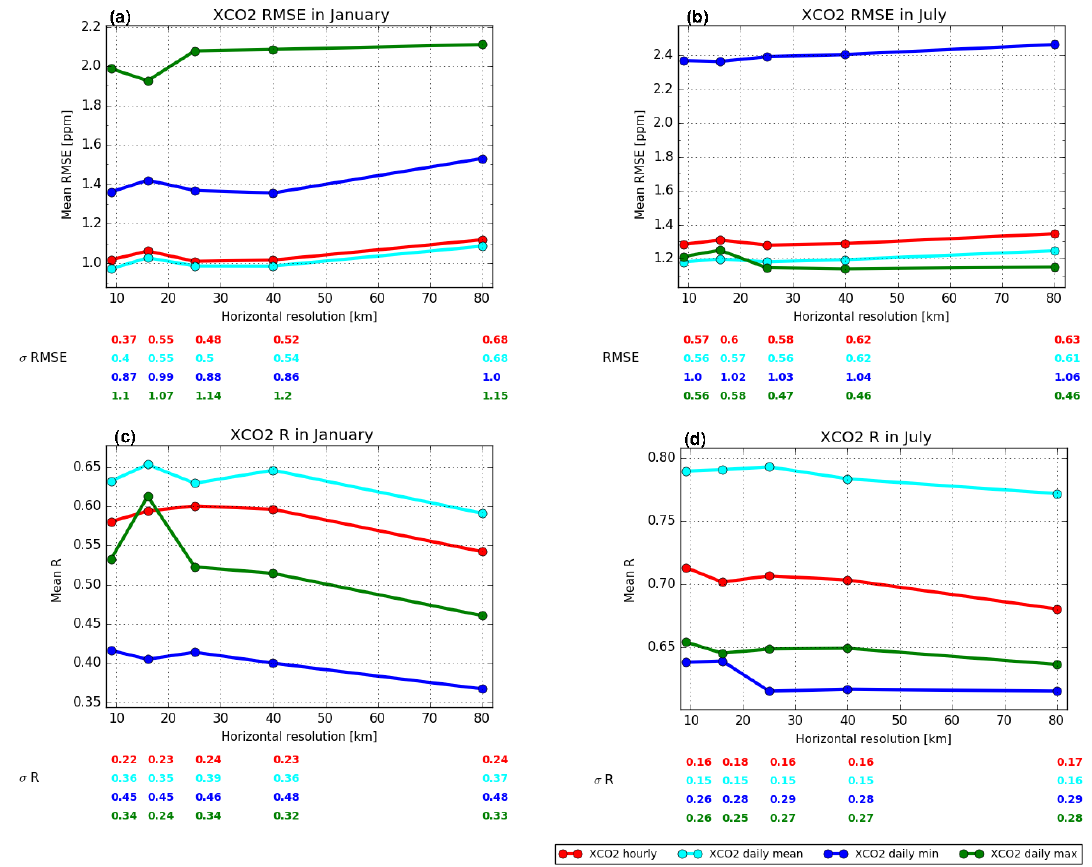
Figure 7. Mean RMSE of XCO 2 (ppm) and Pearson’s correlation coefficient R with respect to observations from 18 TCCON stations (see Table A3) at different model resolutions in (a) January and (b) July. The standard deviation of the plotted variable from each station is shown by the numbers below the horizontal resolution for each temporal resolution (hourly, daily mean, daily min and daily max). All the model simulations are based on the 1d forecast. Note that different scales are used in each